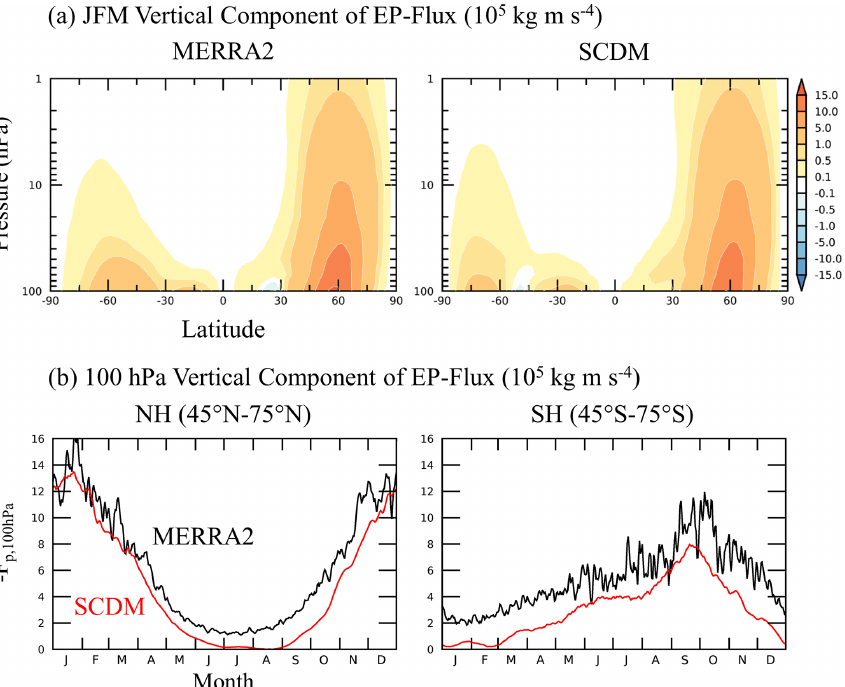
Figure 4. Vertical EP flux component (10 5 kgms − 4 ). Shown are (a) latitude–height cross-sections for January–March means and (b) daily climatologies averaged over the NH (45–75 ◦ N) and the SH (45–75 ◦ S) at